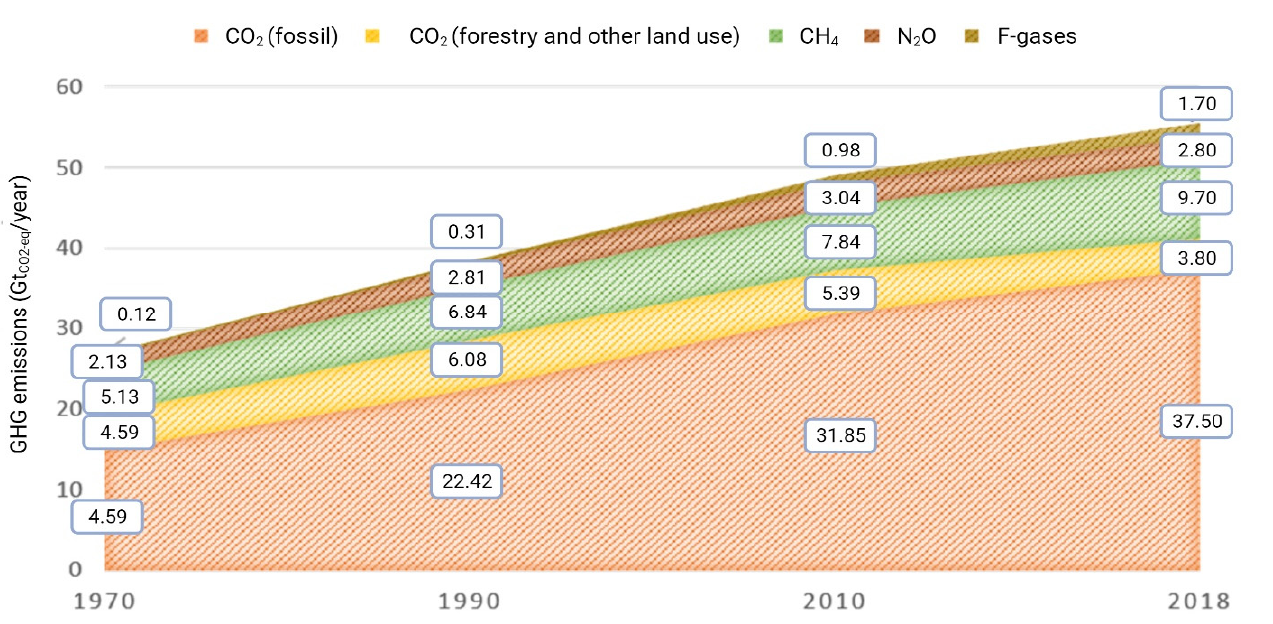
Figure 1. Increase in global emissions of GHG in GtCO 2 -eq/yr between 1970 and 2018, adapted from [1].